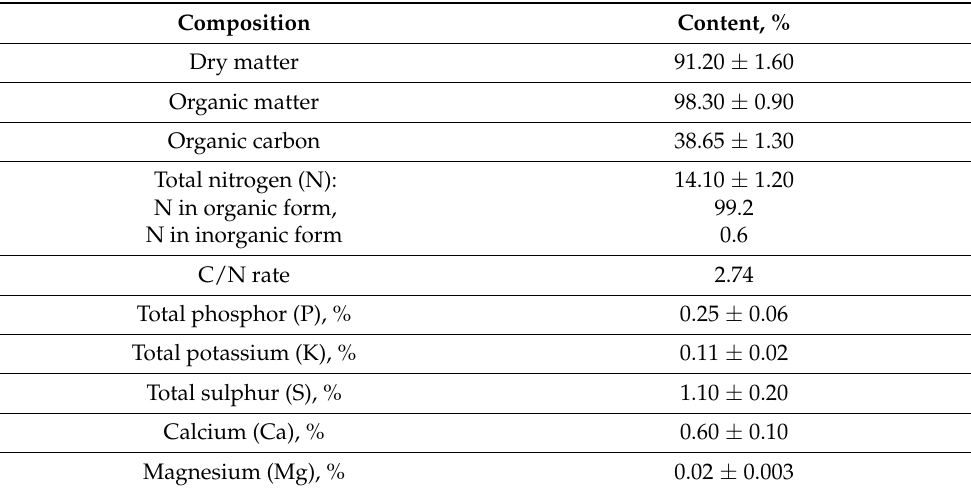
Table 1. Chemical composition of cattle horn shavings. Composition